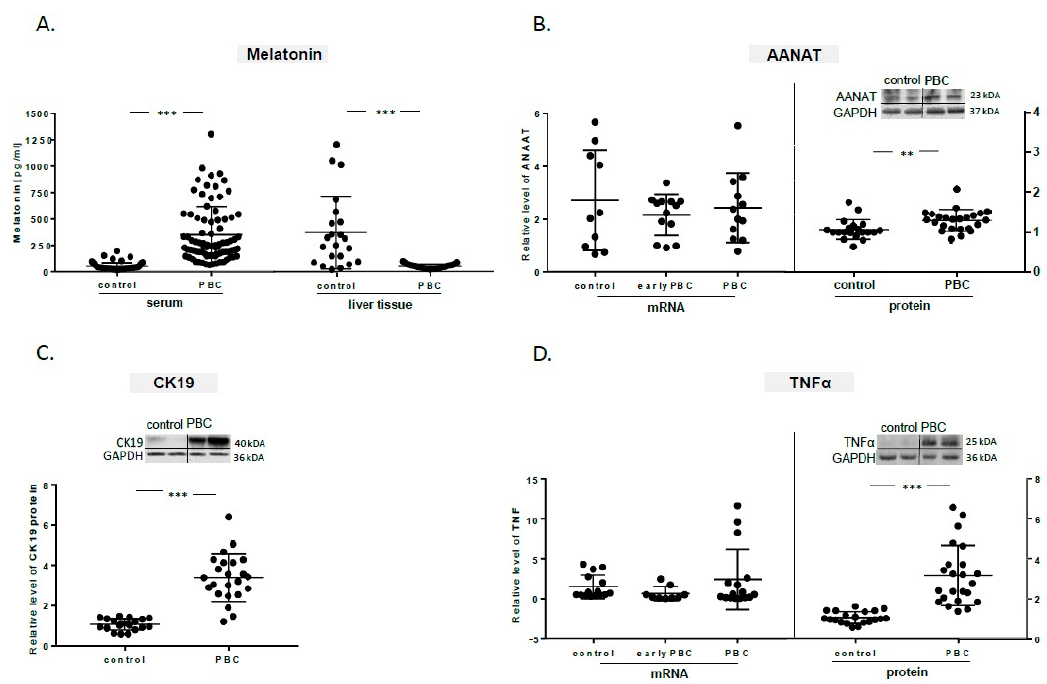
Figure 1. Levels of melatonin, aralkylamine N-acetyltransferase (AANAT), CK19, and TNF α in the livers of patients with primary biliary cholangitis (PBC). ( A ) Serum concentration of melatonin was increased in PBC patients, in contrast to liver tissue where the concentration of this hormone was decreased in comparison to controls. ( B ) The level of AANAT protein was enhanced, whereas the expression of mRNA was not change in either early-stage PBC or cirrhotic PBC. ( C ) The level of the CK19 protein was increased in the livers of PBC patients in comparison to controls. ( D ) The TNF α protein level was upregulated in PBC, while no changes in mRNA expression were observed in early-stage PBC or cirrhotic PBC. Melatonin concentration was evaluated using an ELISA assay, while AANAT, CK19, and TNF α mRNA and protein levels were evaluated using real-time PCR and Western blot, respectively. Values are shown as mean ± SE. ** p < 0.01 and *** p < 0.001. The presence of AANAT was confirmed in the bile ducts (Figure 2A), as well as in regenerative nodules (Figure 2B). TNF α -positive cells were on the perimeter of the nodules (Figure 2E), but was barely detected in the bile ducts (Figure 2F). Antibodies against the cholangiocyte marker cytokeratin